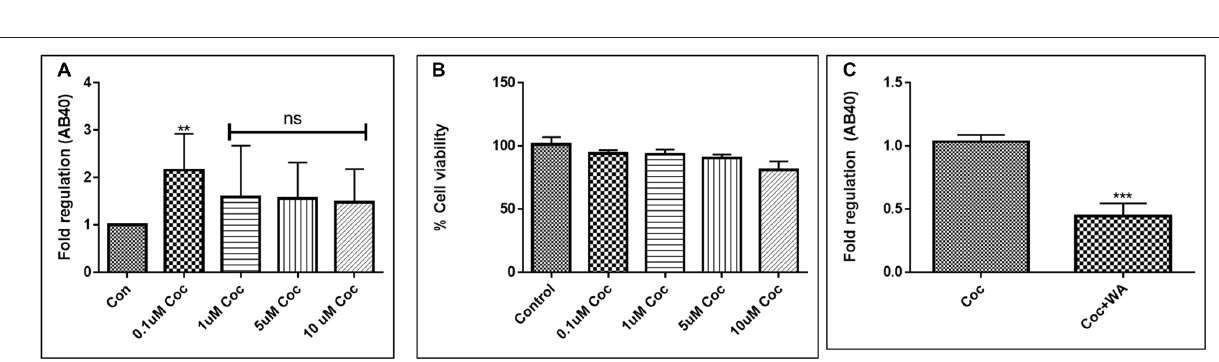
FIGURE 6 | Coc induces increase in secreted A β 40 levels. Similar study pattern of ELISA and flow cytometry, like in the case of HIV-1 Tat, was performed with various concentrations of coc to choose an optimized dose of coc for further studies. (A) Coc increases A β 1–40 secretion. Coc (0.1–10 µ M) increased the secreted A β 1–40 but the significant increase was found in the samples treated with 0.1 µ M coc. (B) Cellular toxicity assay showing viability of the cells in the coc treated samples. (C) 2 µ M WA reduced the coc (0.1 µ M) induced A β 1–40 levels significantly when compared to coc only treated samples ( ∗∗ p ≤ 0.01; ∗∗∗ p ≤ 0.001; ns, not